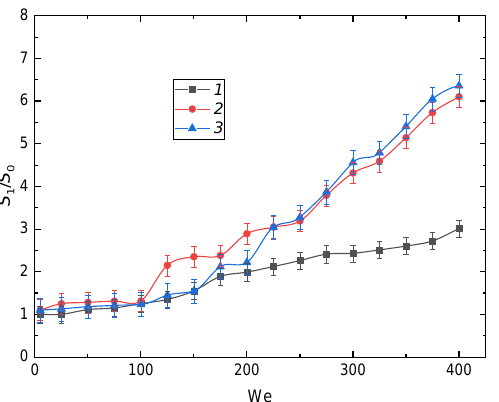
Figure 12. Comparison of breakup characteristics of a single drop and a group of smaller droplets impinging on a surface as a function of S 1 / S 0 (We): 1 — single drop ( V 0 ≈ 600 µl), 2 — three drops ( V 0 ≈ 200 µl for each one), 3 — two drops ( V 0 ≈ 200 µl for each one).